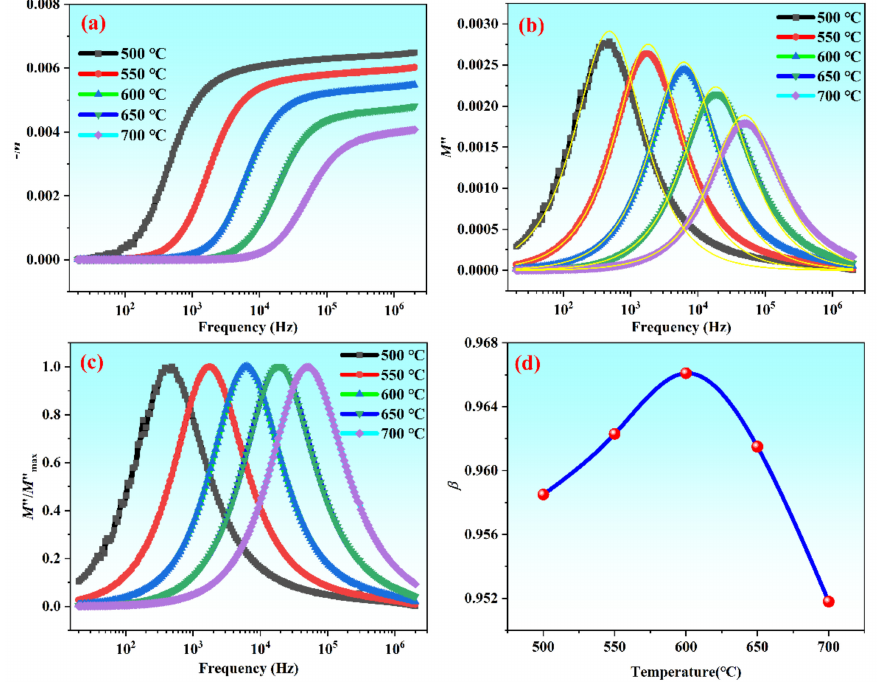
Figure 6. Electrical modulus spectroscopy of the composition with x = 0.06 measured at different temperatures: ( a ) − M (cid:48) ; ( b ) M (cid:48)(cid:48) ; ( c ) M (cid:48)(cid:48) /M (cid:48)(cid:48) max ; ( d ) temperature dependence of β